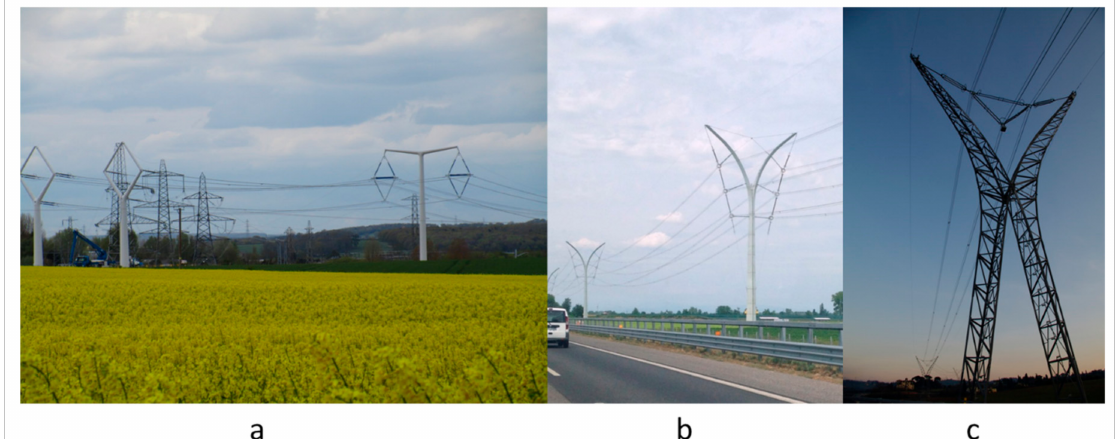
Figure 1. Examples of already installed pylons with alternative designs: ( a ) T-pylon, installed in the UK [15]; ( b ) Rosental pylon, installed in Italy by Italian energy company Terna SpA [16]; ( c ) Foster pylon, installed in Italy by Terna SpA (Photo credits: Terna SpA)